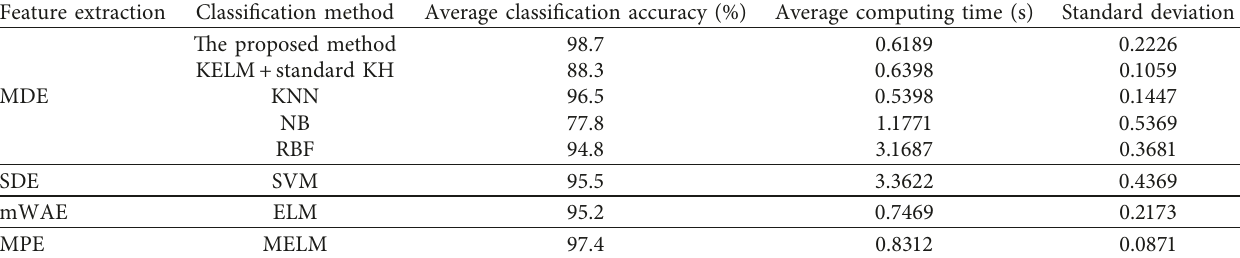
Table 4: Average classification accuracy of different algorithms.